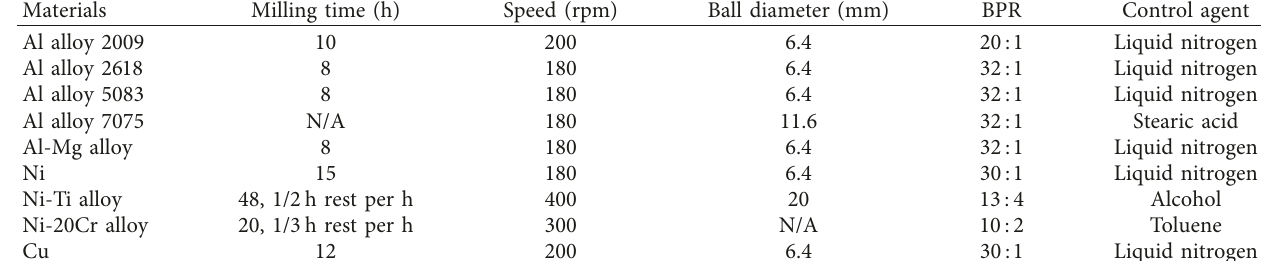
Table 1: Nanocrystalline powders for cold spray and the milling conditions [14, 22–31].